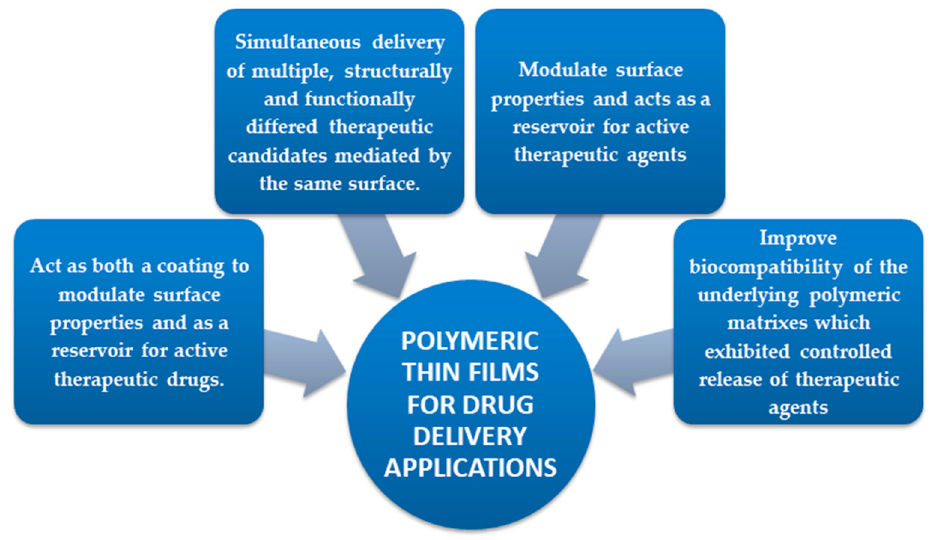
Figure 1. Benefits of surface biofunctionalization with polymeric coatings.